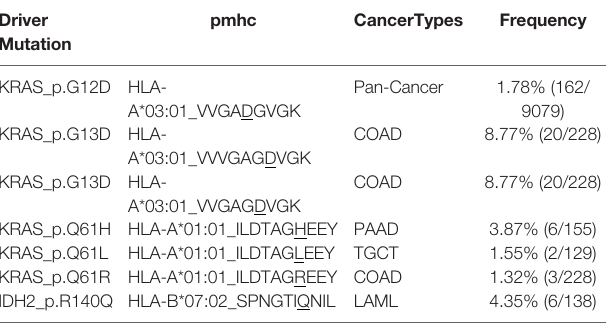
TABLE 2 | Validated immunogenic neoantigens derived from driver mutations. Driver